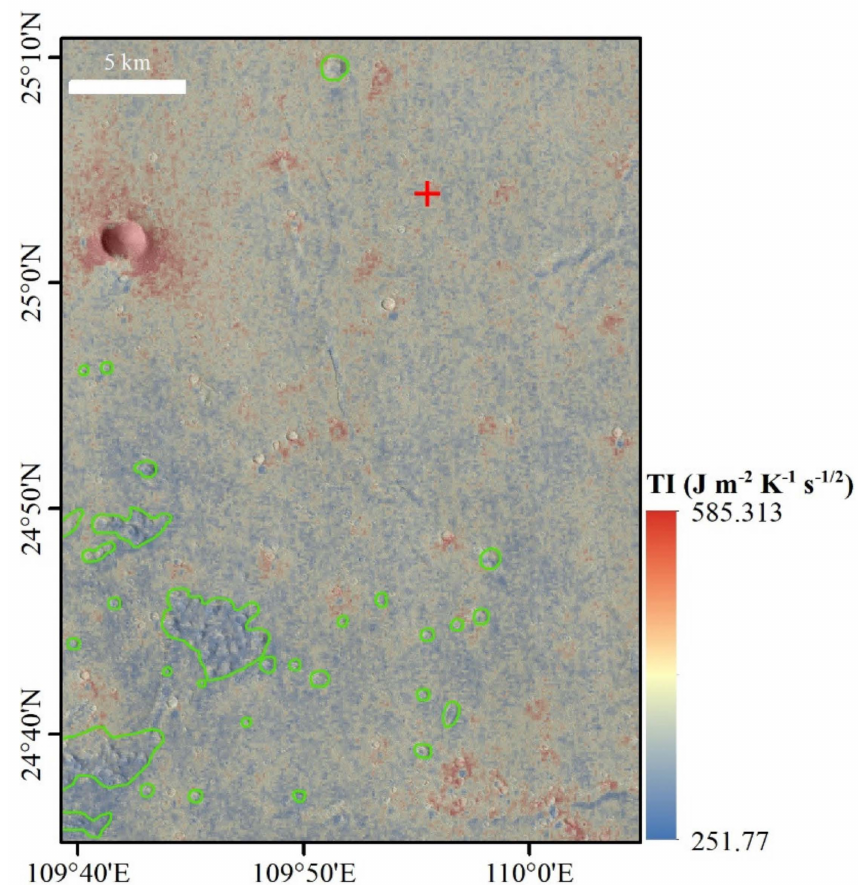
Figure 7. THEMIS − derived thermal inertia map of the landing area. This map overlays the HiRIC DOM, showing the surface physical nature characteristics around the Zhurong landing site. Green lines outlined the cone fields, which present lower TI values. The red cross represents the Zhurong landing